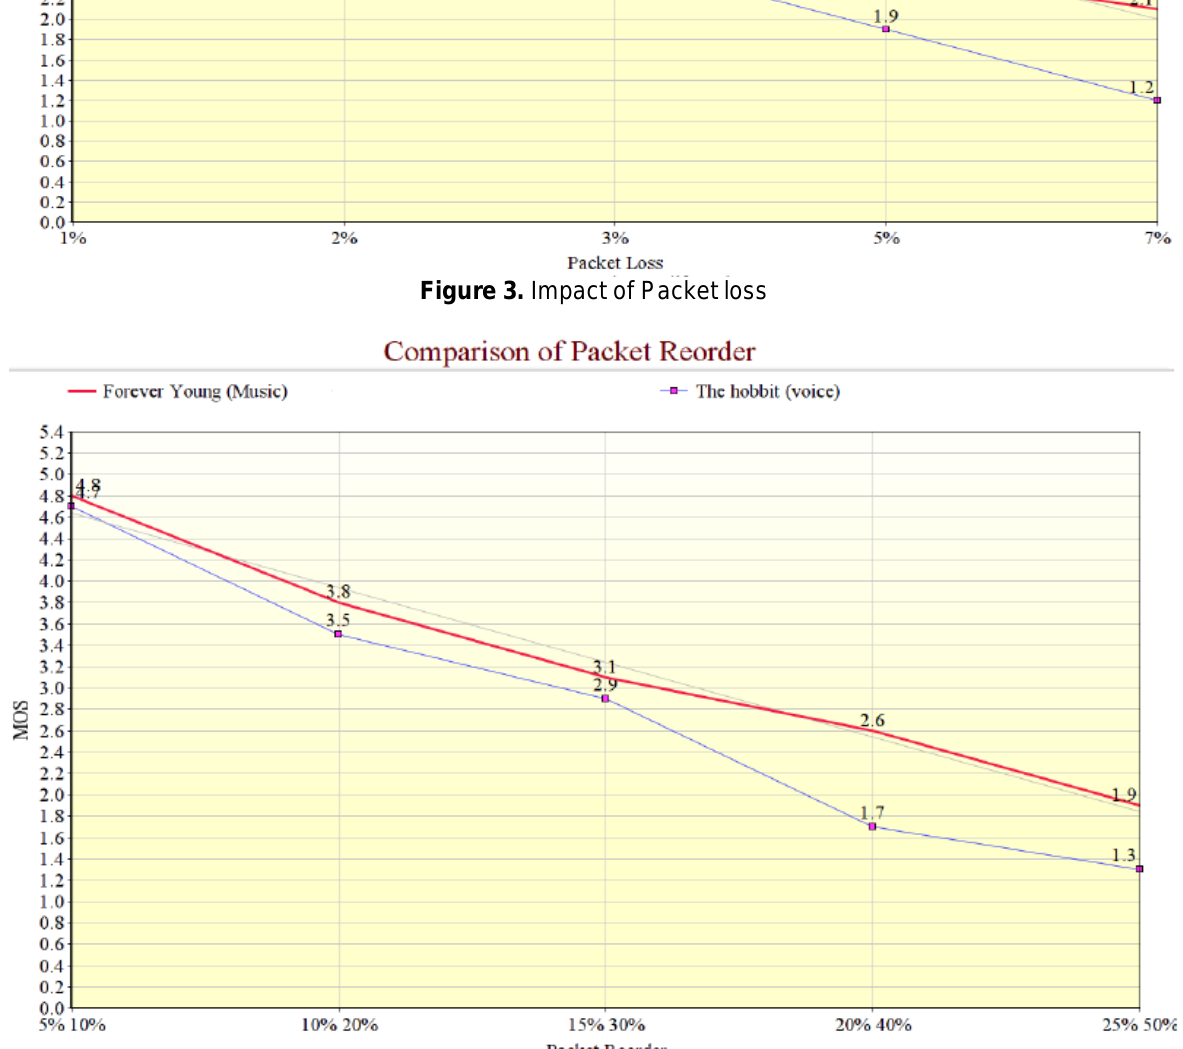
Figure 4. Impact of Packet